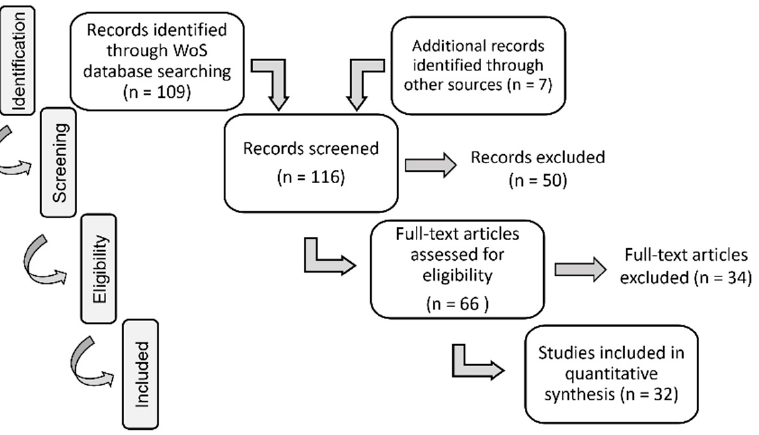
Figure 1. The PRISMA flow diagram with indicated number of publications in different phases of the systematic literature review.